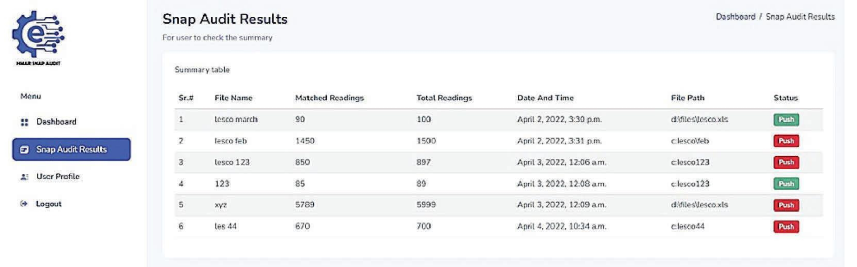
Figure 5: Local application for auditing processes.